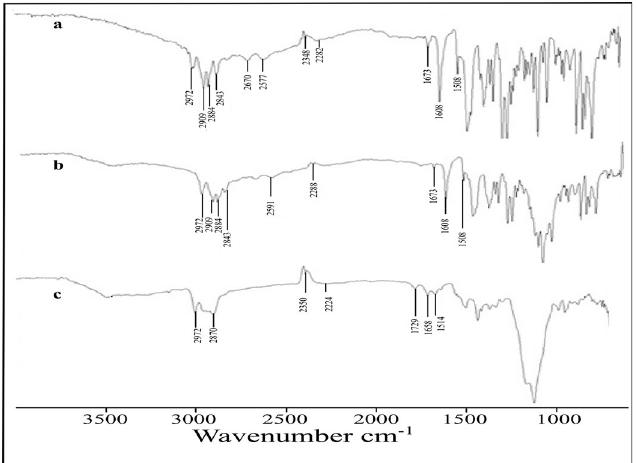
Fig 6. FTIR spectra of Pentazocine (a), Physical mixture (b), and optimized microsphere formulation (c).